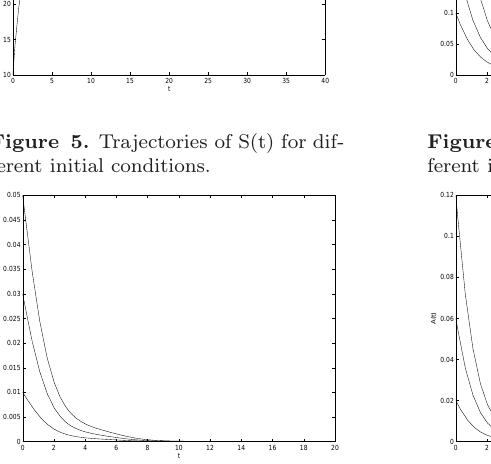
Figure 7. Trajectories of J(t) for dif- ferent initial conditions.